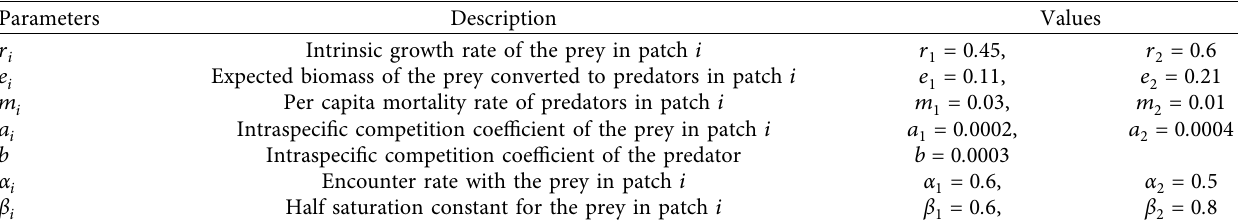
Table 1: Physical interpretation of the parameters.